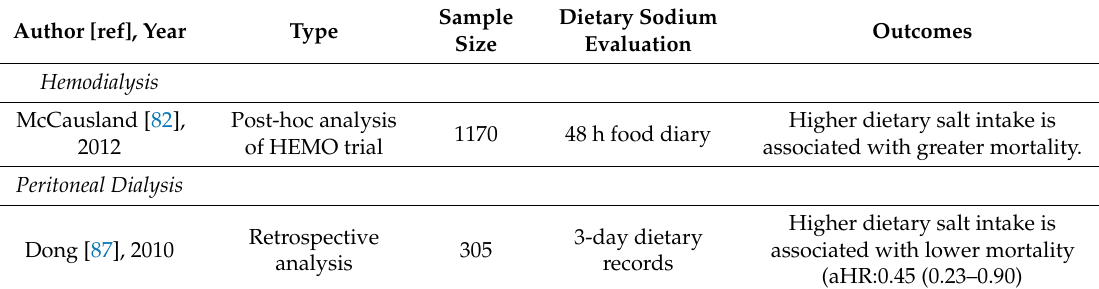
Table 3. Studies evaluating the e ff ect of urinary sodium excretion (UNaV) on mortality in ESKD